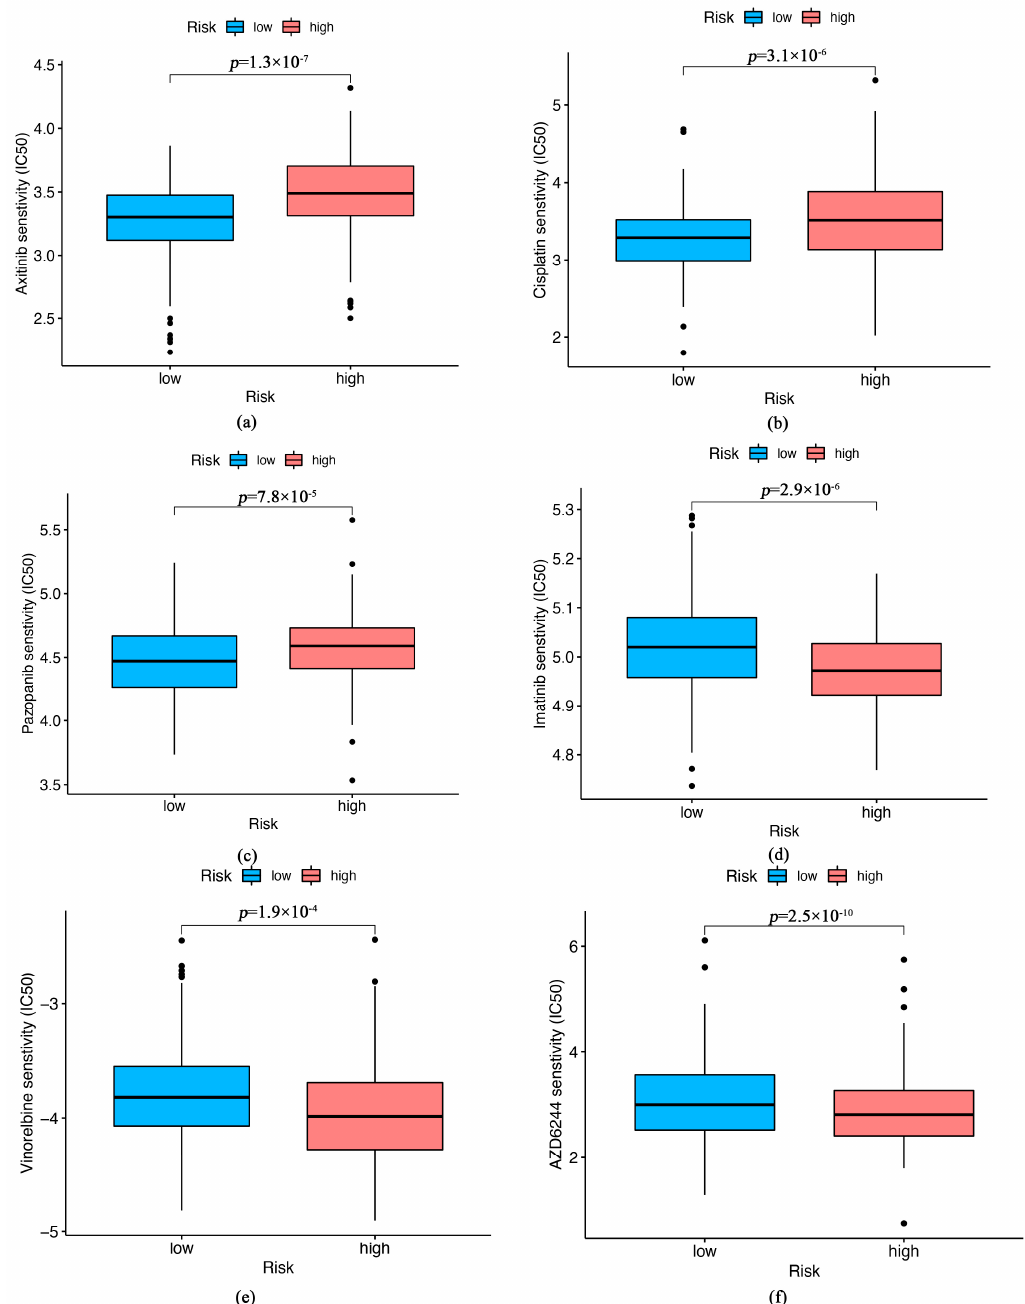
Figure 8. Chemotherapy drug sensitivity analysis. ( a – c ) The IC50 of Gefitinib, Mitomycin, and Parthenolide in patients with both risk groups. ( d – f ) The IC50 of Docetaxel, Sorafenib, and Imatinib in patients with both risk groups.